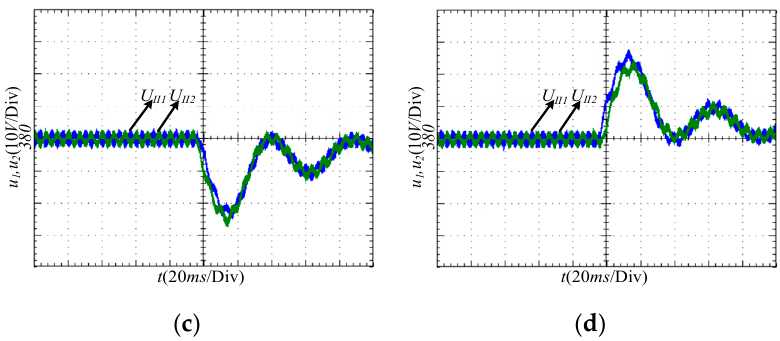
Figure 19. Waveforms of U 1 and U 2 when 𝐼 (cid:3031)∗ and 𝐼 (cid:3044)∗ change. ( a ) From 0 A/0 A to 50 A/50 A. ( b ) From 0 A/0 A to − 50 A / − 50 A. ( c ) From − 50 A/ − 50 A to 50 A/50 A. ( d ) From 50 A/50 A to − 50 A/ − 50 A.